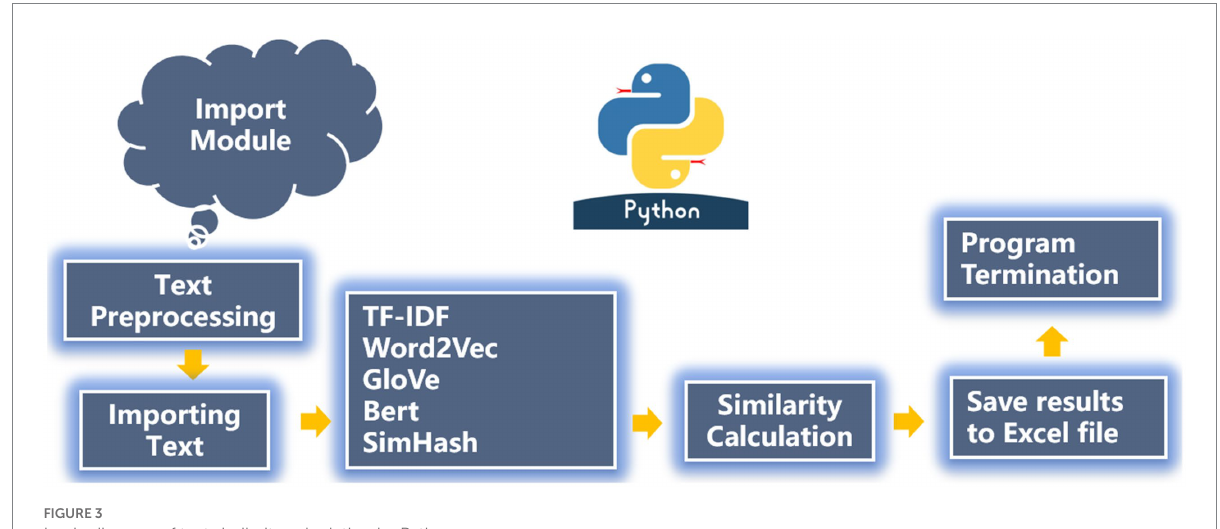
FIGURE 3 Logic diagram of text similarity calculation by